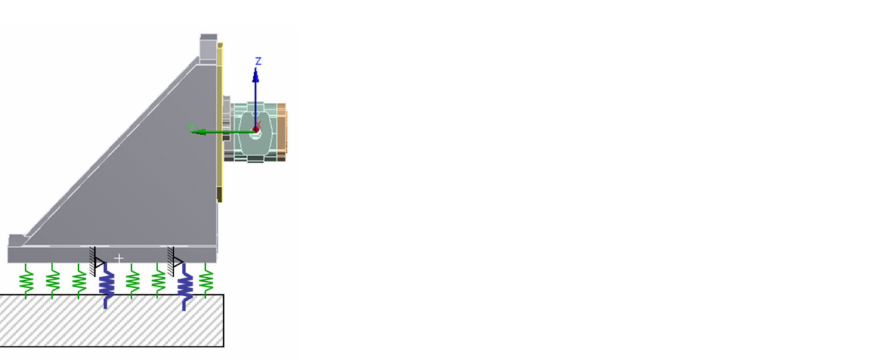
Figure 13. Numerical and experimental modal analysis setup for the pump mounted in the sound chamber.